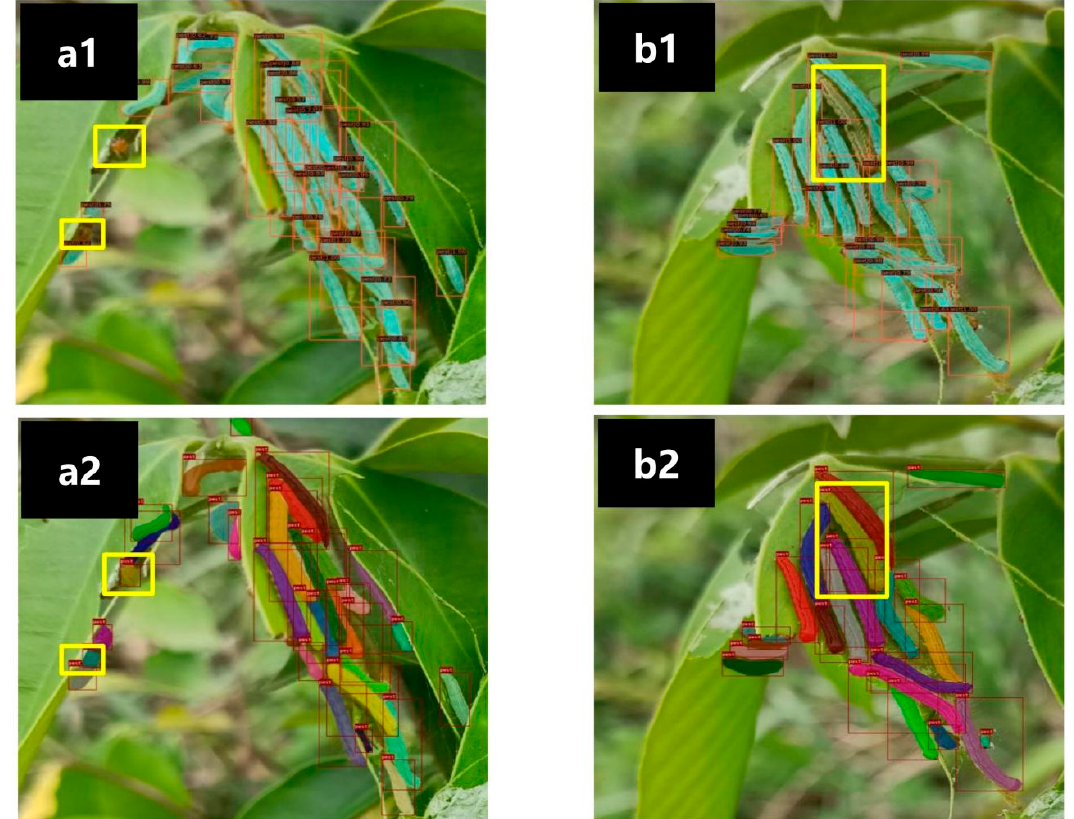
Figure 6. Examples of mis-segmentation: ( a1 ) Segmentation result of only the heads of Heortia vitetiae larvae caught in images; ( a2 ) The ground truth of ( a1 ); ( b1 ) The segmentation result for cases in which the backdrop color is comparable to that of multiple pests; ( b2 ) The ground truth of ( b1 ).